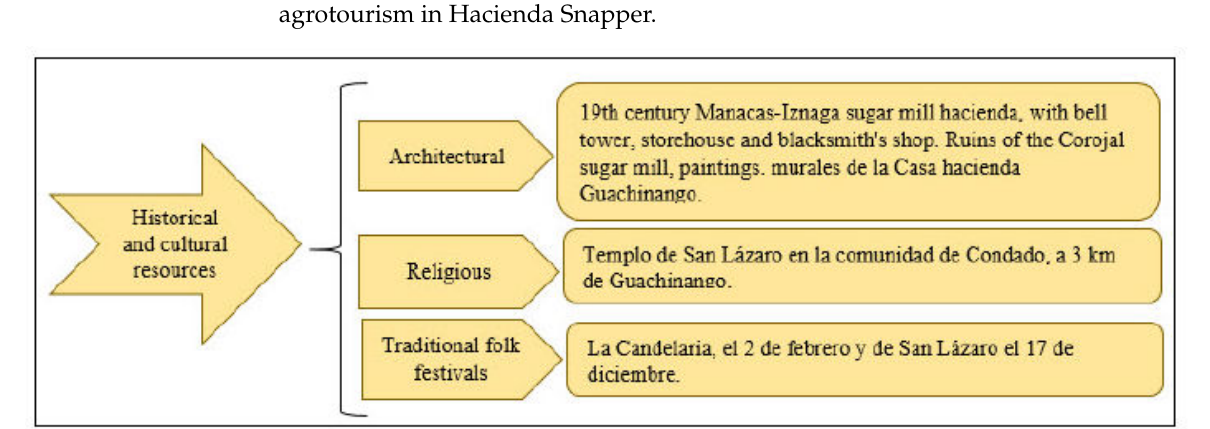
Figure 4. Historical–cultural resources available for agrotourism at Hacienda Guachinango. Source: own elaboration based on the results of the inventory of resources at Hacienda Guachinango.